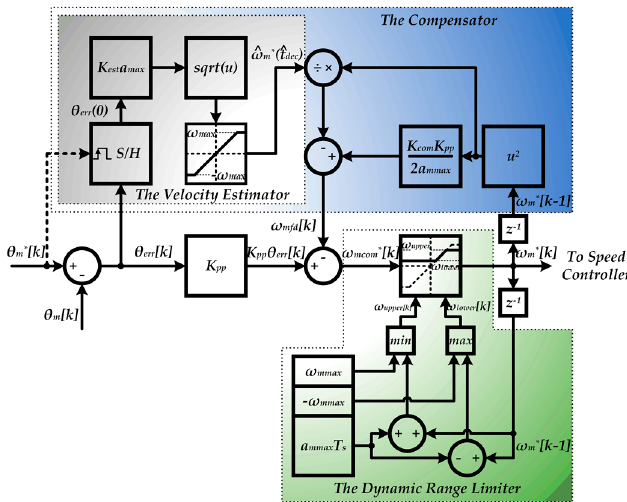
The initial position error is held when the position reference change is detected. From the initial position error and (22), the velocity at the deceleration start time is estimated. The estimated velocity and (19) consist of the main compensator.